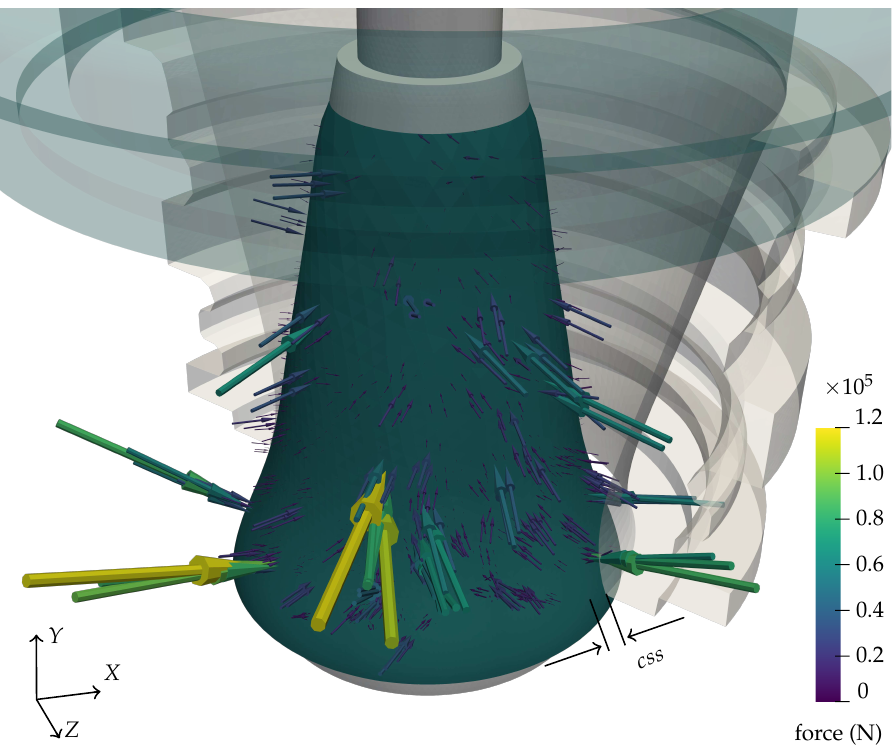
Figure 9. Nodal forces at simulation time t = 9.86 s. The length and the color of the vector represent the magnitude of the force vectors. The position of the closed side setting, css , is also